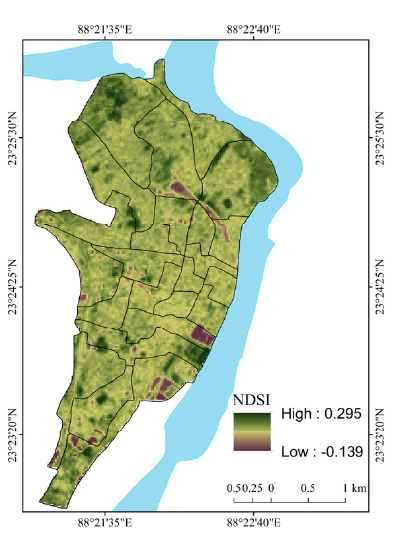
Figure 39. NDSI (2015).